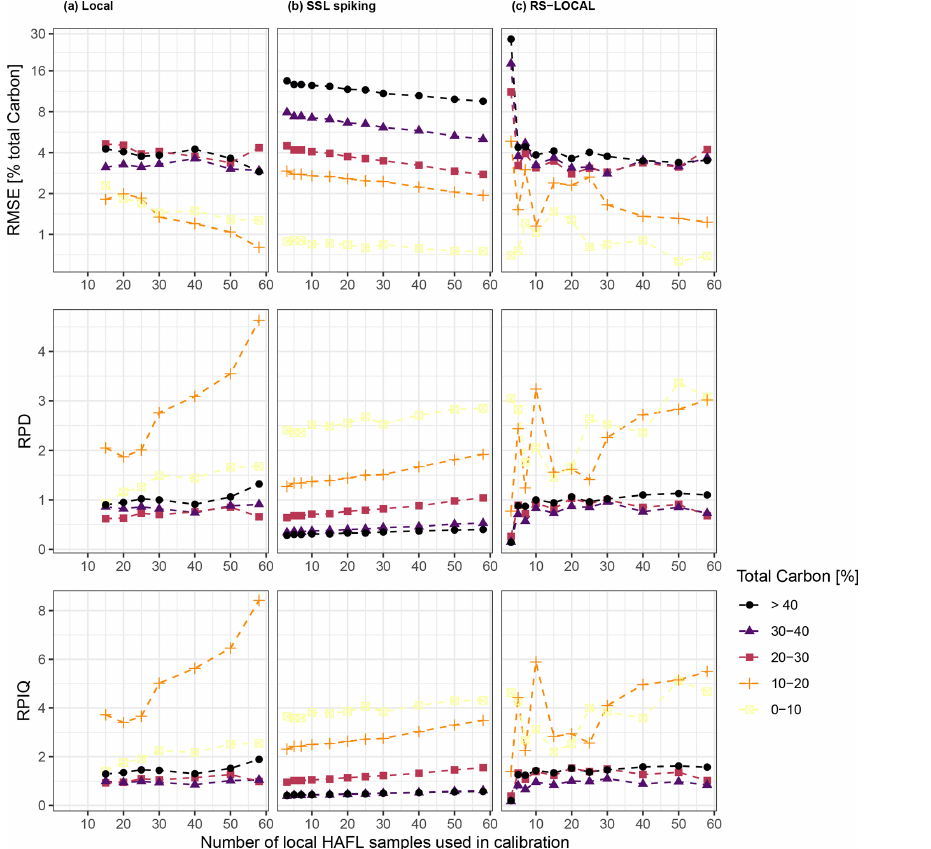
Figure 9. RMSE (in percent of total carbon and logarithmic scale), RPD and RPIQ of validation results vs. the number of local HAFL samples used in local HAFL (a) , local combined with SSL (b) and RS-LOCAL subsets (c) , where k = 100. Observations ( Y ) were grouped in increments of 10% SC, and the validation metrics were calculated separately for each group. Dashed lines between data points do not represent real measurements and are only for visual